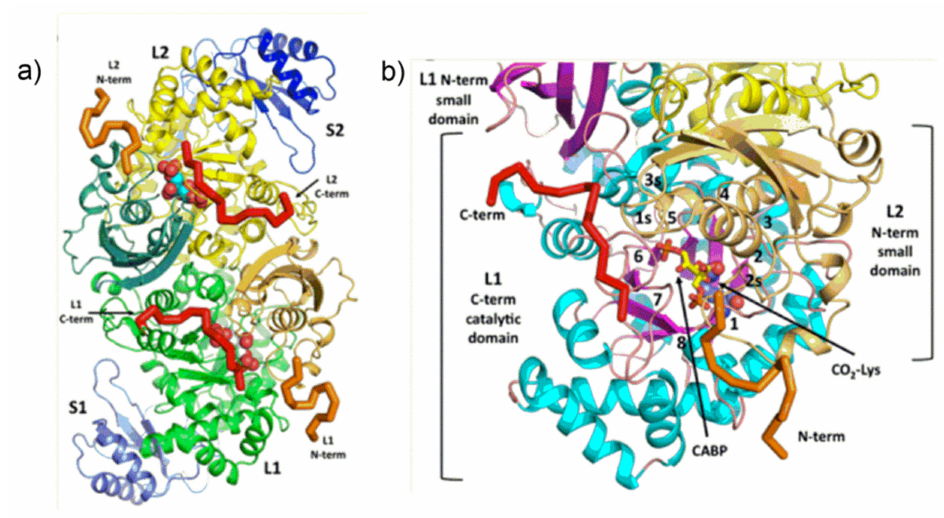
Figure 3. ( a ) Ribbon representation showing the quaternary structure of the L 2 S 2 unit of Rubisco from Galdieria sulphuraria viewed down the two-fold axis. The two L subunits are represented in green (L1) and yellow (L2) with the highlighted N-terminal (orange) and C-terminal (red) regions. S1 and S2 subunits are represented in blue; ( b ) close-up of the L1 subunit (heavenly color) evidencing the TIM barrel domain. N- and C-terminal tails are marked in orange and red, respectively. Loop numbering is highlighted. N-terminal of the L2 subunit (L2 N-term small domain, represented in yellow color) is located at the mouth of the TIM barrel of the L1 subunit. Each L subunit guests one active site. In ( b ) the substrate mimic 2-carboxy-D-arabinitol 1,5-bisphosphate (2CABP) is shown as a bond-stick model and pointed by a black arrow. The CO 2 -Lys201 residue is also pointed by a black arrow. (Figure from ref. [15], adapted and used by permission of PNAS (copyright © 2012). The Rubisco Small